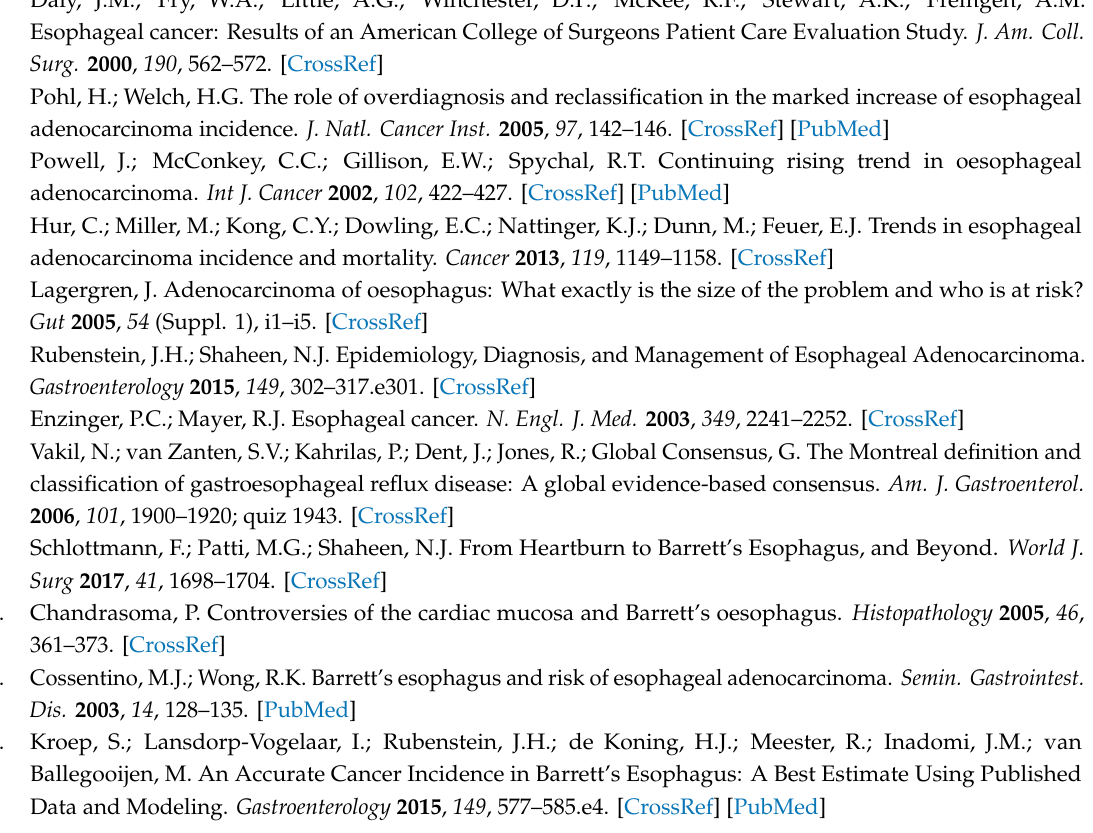
Table S1: Targeted lipidomics methods. Table S2: Tissue pathology grades. Tissue and serum lipidomics data are available on Metabolomics Workbench with Study IDs ST001323 and